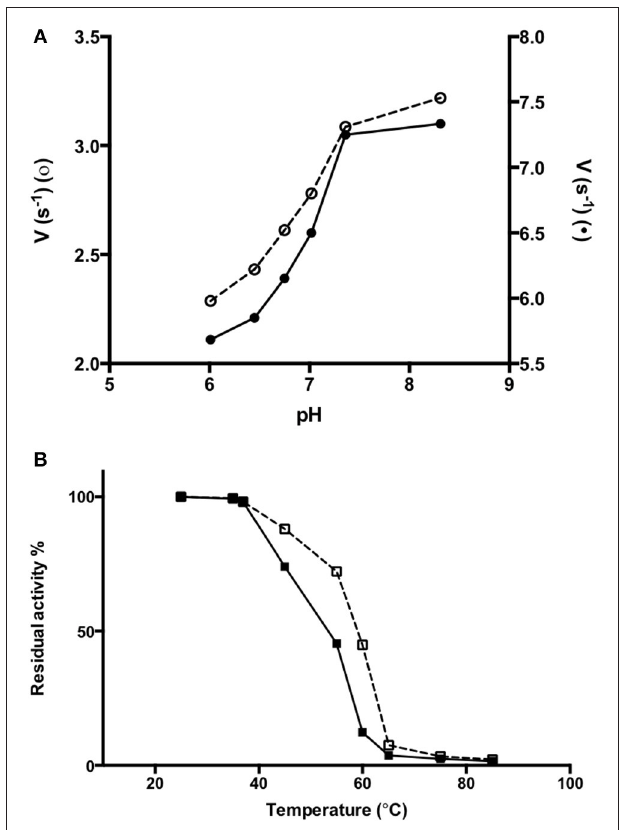
FIGURE 6 | Activity of AroH as a function of pH and temperature. (A) AroH activity as a function of pH. The activity measurements were performed in KP 0.1M at 25 ◦ C. The amino donor used were L-tryptophan (o) or L-phenylalanine (•) while the amino acceptor was α -ketoglutarate. The reaction was stopped in 10% TCA (v/v) after 10min. L-glutamate determination was performed as reported in Material and Methods. (B) The figure shows the residual enzymatic activity of AroH in the holo-( (cid:3) ) and apo-( (cid:4) ) form in KP 0.1M pH 7.4 at 25 ◦ C, upon 10min incubation in the temperature range 25–85 ◦ C. In both panels the continuous and dashed line indicate the holo- or apo-form,